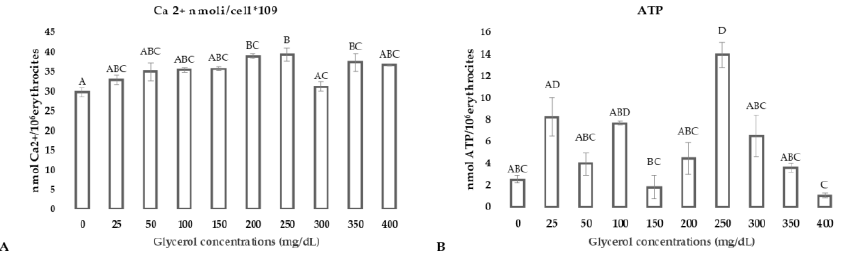
Figure 4. Intracellular Ca 2+ ( panel A ) and ATP concentration ( panel B ) in RBCs after incubation in media supplemented with glycerol in concentrations ranging from 0 to 400 mg/dL. Uppercase letters indicate significant differences between groups: Ca 2+ p < 0.05 ATP p < 0.05; (one-way ANOVA–Tukey post hoc test) .